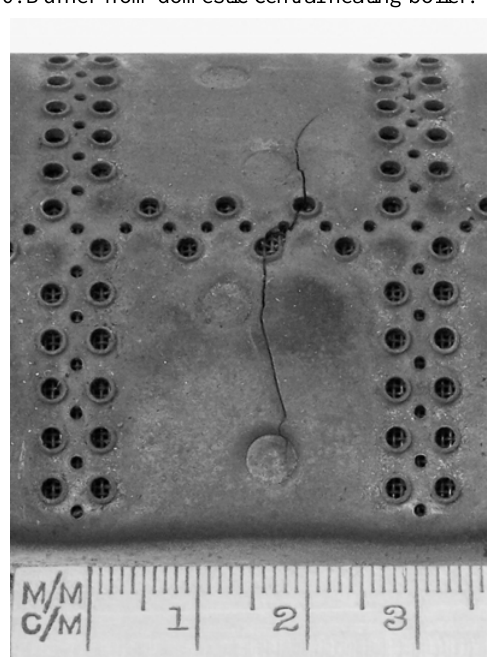
Figure 15. Angle notch Charpy specimen, crack origin at notch corner.